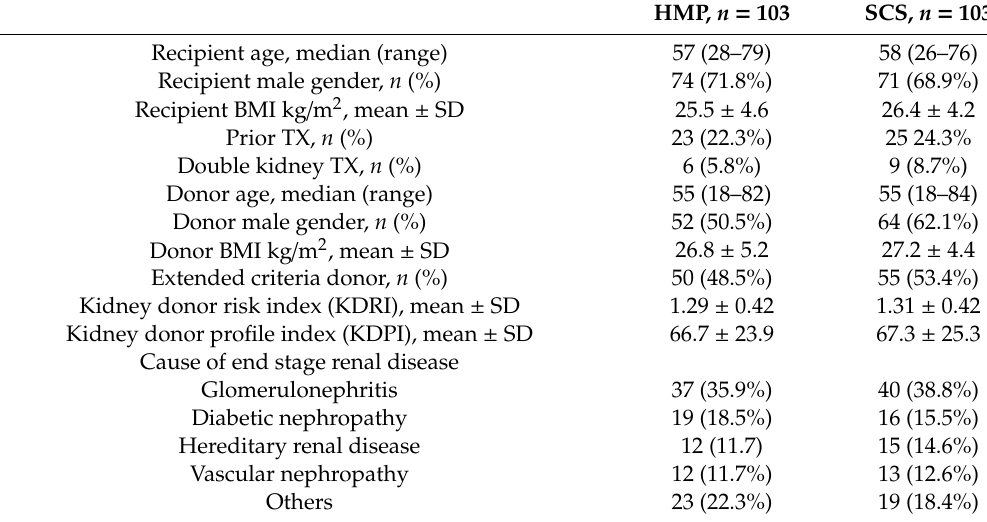
Table 3. Donor and recipient demographics and transplant factors stratified by HMP and SCS.